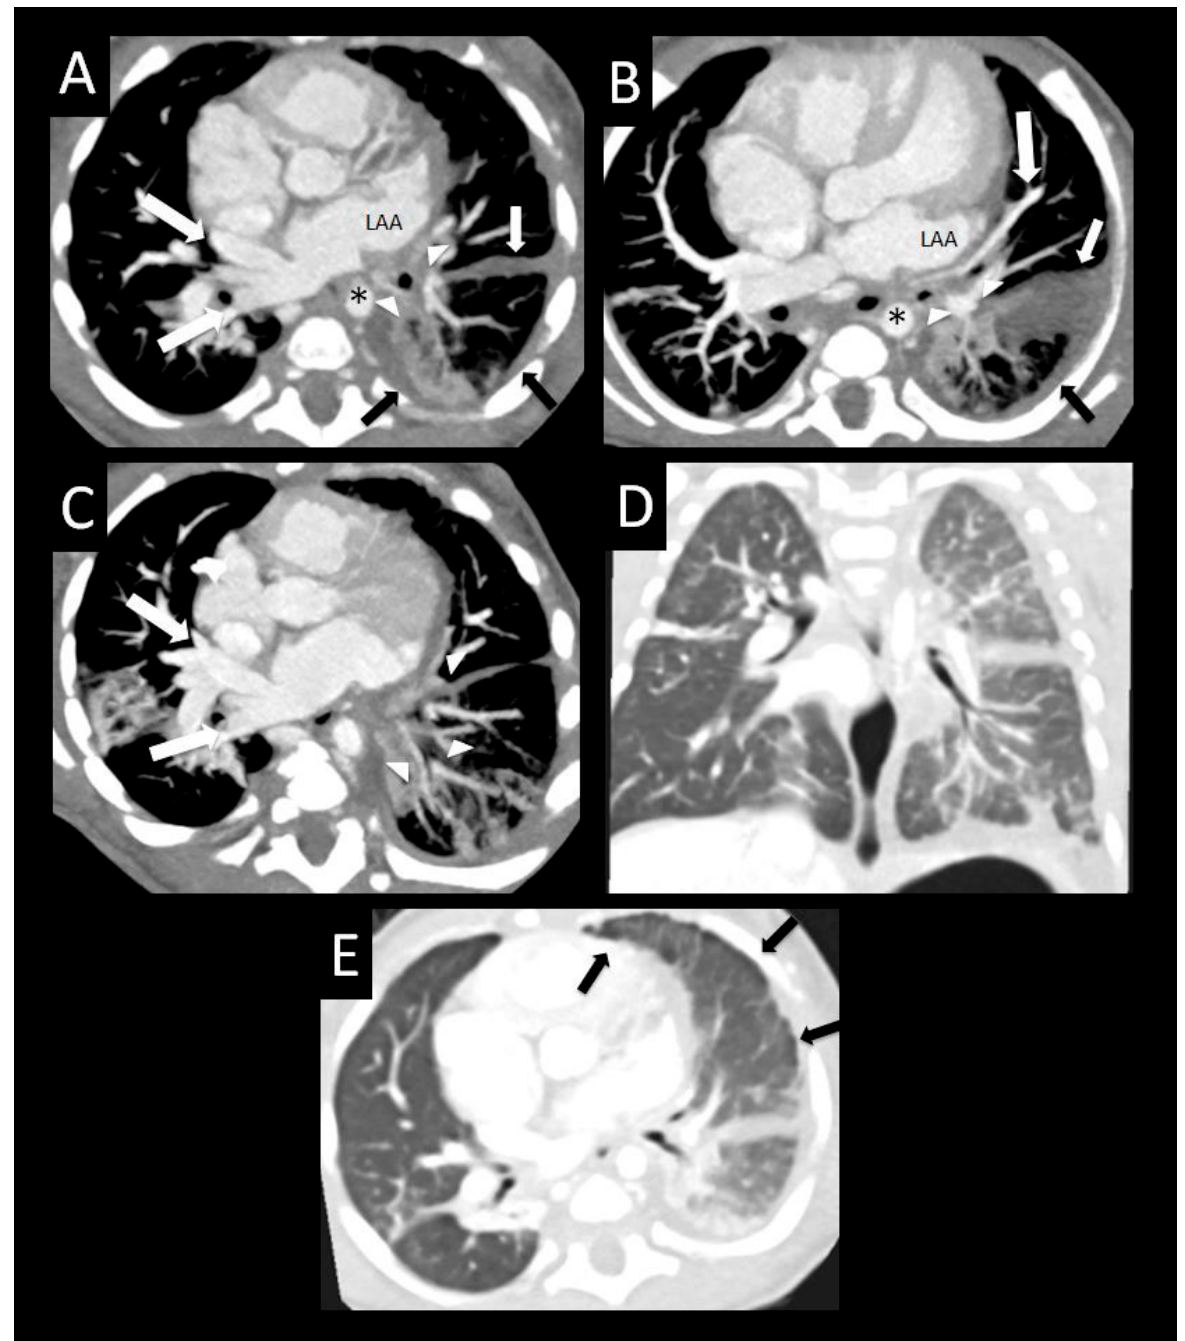
Figure 11. Pulmonary vein stenosis after repair of totally anomalous pulmonary venous connection. Central atretic left pulmonary vein confluence anterior to the descending aorta (*) with peripheral hypoplastic lingular and lower lobe branches (arrowheads) surrounded by perihilar induration on axial imaging ( A ). Diffusely small peripheral left upper pulmonary vein (large arrow) coursing between a severely dilated left atrial appendage and left upper and lower lobe bronchi (arrowheads) on axial imaging ( B ). Left-sided diffuse pleural and fissural thickening (arrows ( A , B )). Diffuse hypoplasia and relative decreased enhancement of the branches of the lingular and left lower pulmonary vein (arrowheads), with large right-sided pulmonary veins on axial imaging (large arrows ( A , C )). Coronal ( D ) and axial ( E ) images with lung windows show diffuse left lung edema with surrounding pleural and fissural thickening (arrows). LAA = left atrial appendage.